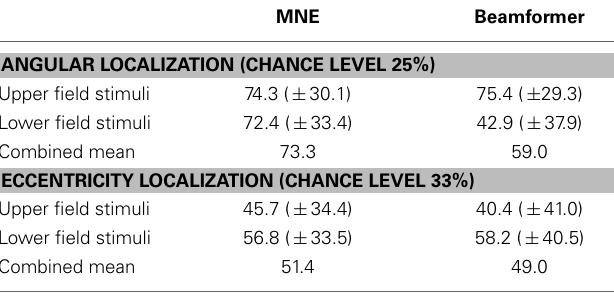
Table 4 | Localization accuracy for quarter-ring stimuli. MNE